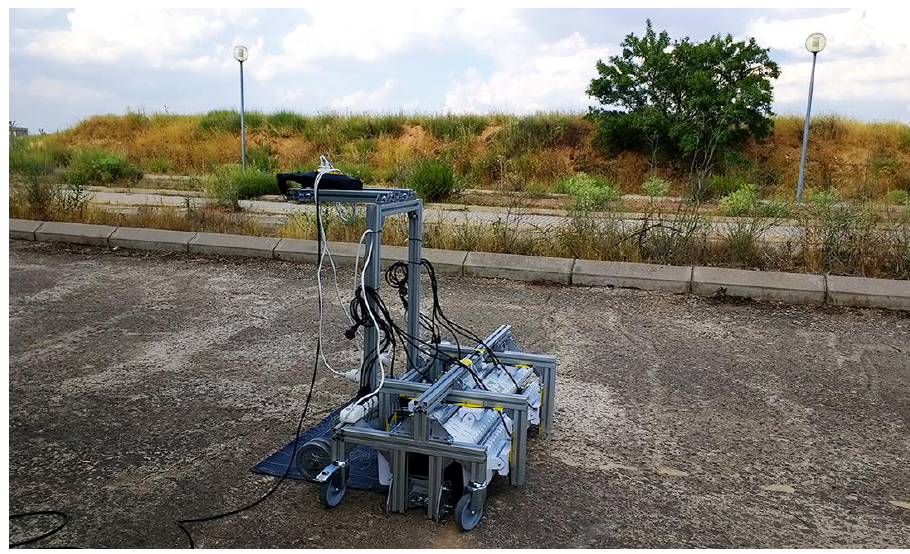
Figure 21. Prototype connected and ready for testing.